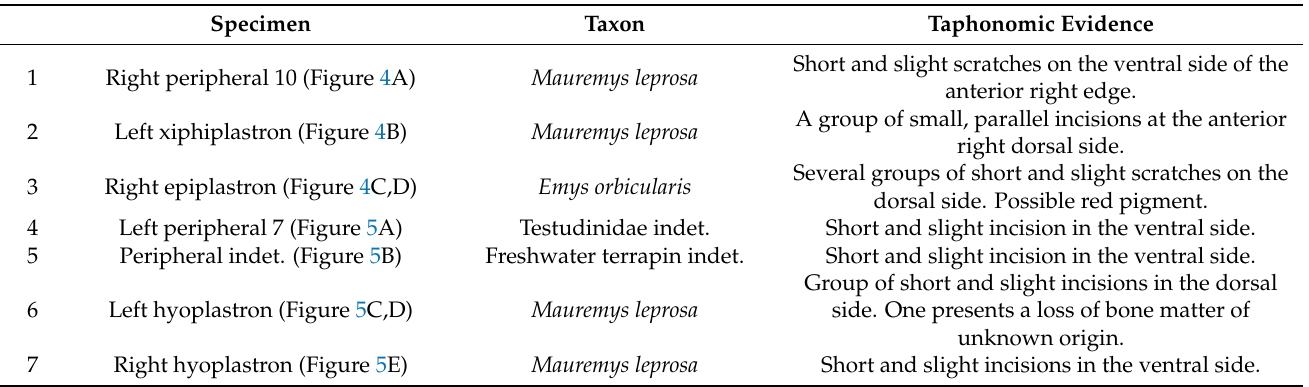
Table 2. Potential anthropic alterations description and location on turtle remains from the Middle Paleolithic site of Mealhada (Coimbra, central Portugal).